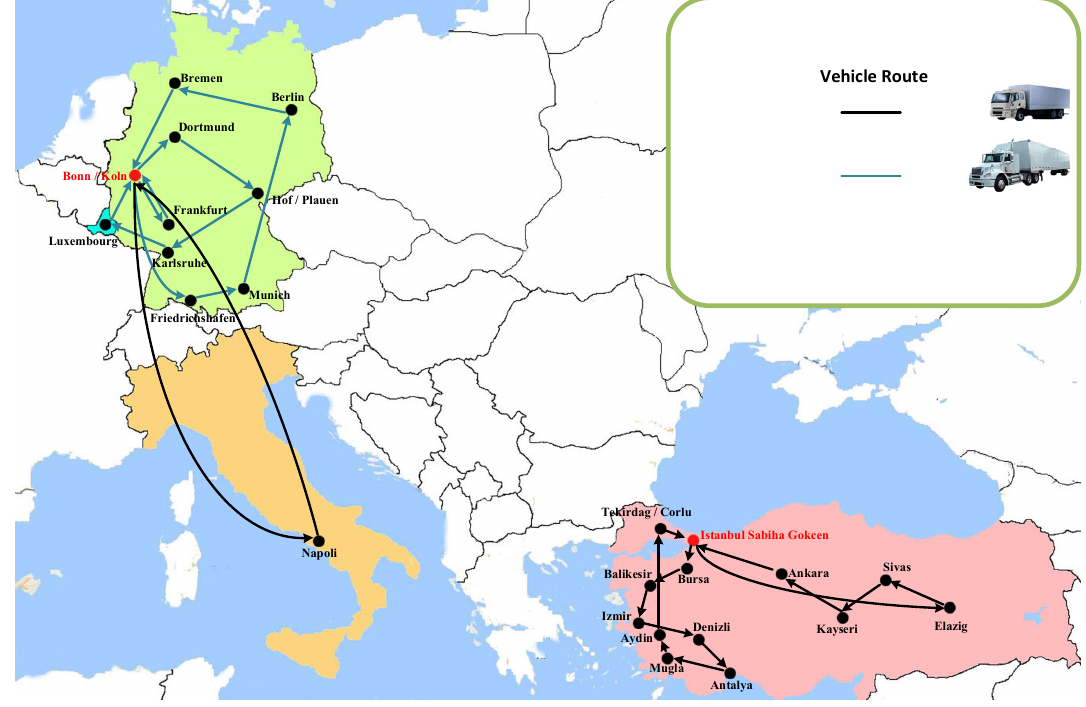
Fig. 13. The routes found by the HGA-VNS algorithm for the normal demand